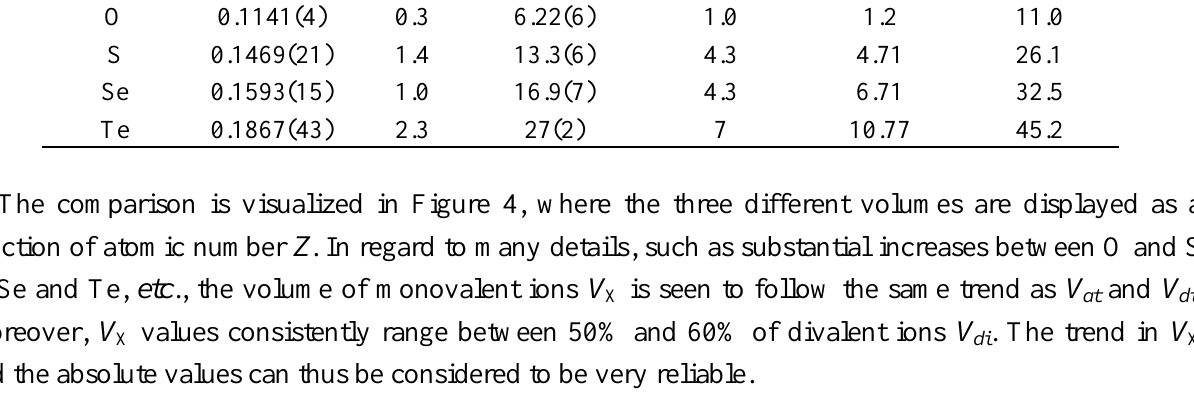
in %. Numbers in X